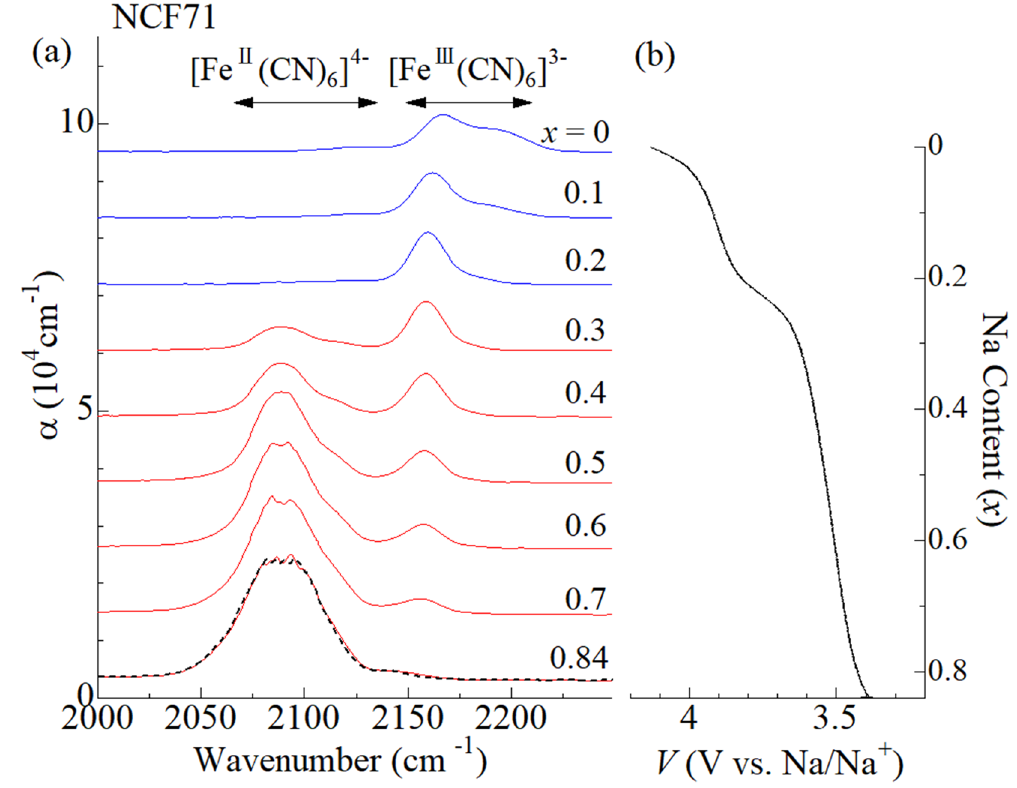
Figure 3. (a) In situ IR spectra of the NCF71 film at 293 K against x in the oxidation process from x = 0.84 to x = 0. Black broken curve at x = 0.84 was obtained after the measurement. α is absorption coefficient; α = where d is the film thickness, I 0 is the incident beam intensity, and I is the transmitted beam intensity, respectively. Spectra are vertically shifted for clarity. The horizontal arrows indicate the empirical region for the CN - stretching modes in [Fe II (CN) 6 ] 4- and [Fe III (CN) 6 ] 3- , respectively. (b) Charge curve of the NCF71 film at 293 K against x at 1.9 C. The voltages of the electrochemical cell were scaled to vs. Na/Na +